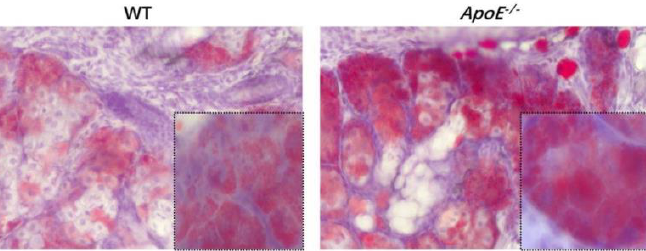
Figure 2. Oil red staining results of normal and ApoE -/- MGD mice. The results showed that ApoE -/- MGD mice had more obvious congestion of eyelid fat and a greater infiltration of inflammatory cells than WT mice.